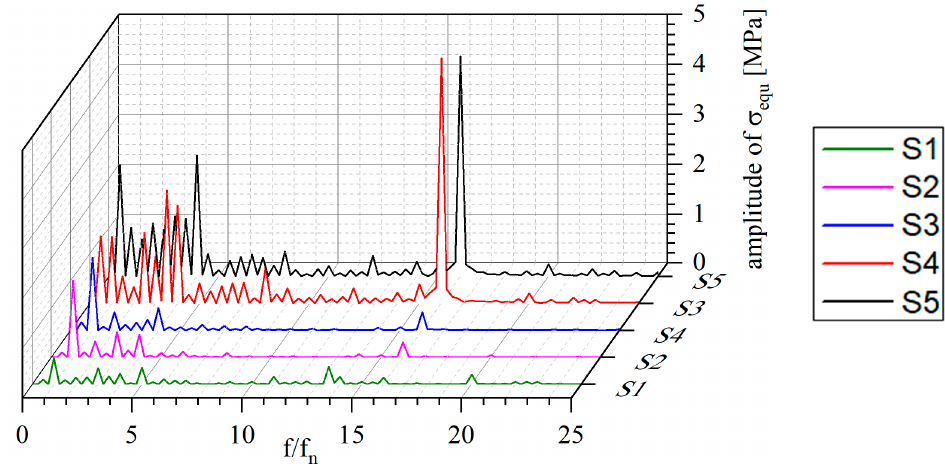
Figure 18. Frequency domain diagram of dynamic stresses at TP6.